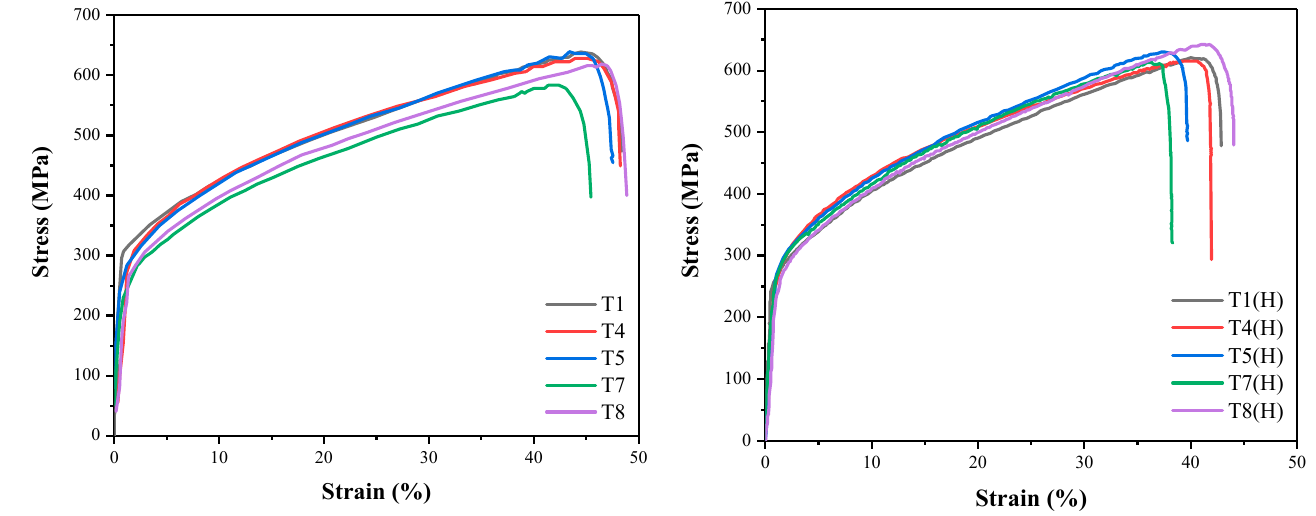
Figure 7. Stress–strain curves of TIG welds before and after hydrogen charging.